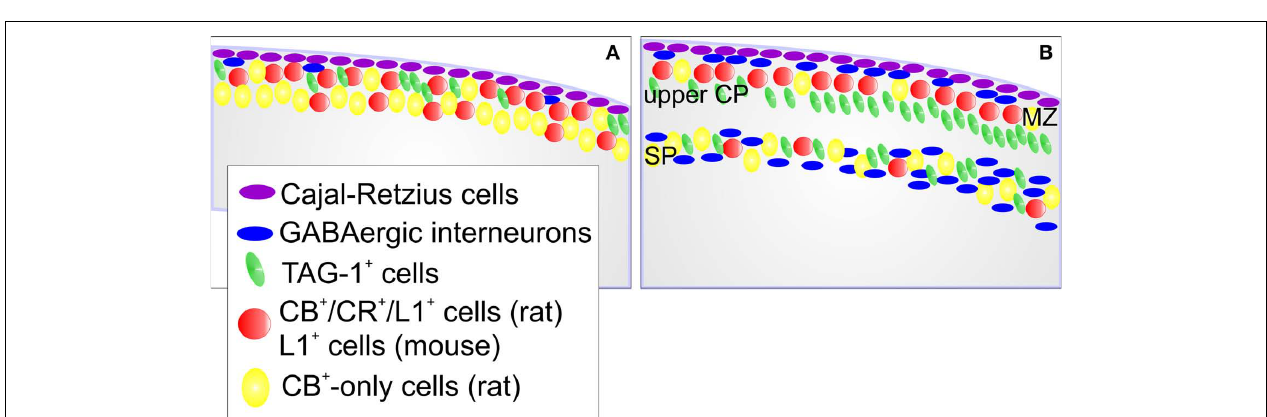
FIGURE 10 | Scheme of the cellular composition of the preplate and its derivatives in rodents. (A) Preplate stage. Cajal-Retzius cells, and sparse GABAergic interneurons are in a subpial sublayer of the preplate. Cells that express CB, CR and L1 in rats, or the homologue L1 + cells in mice, locate in the upper preplate. TAG-1 + cells are also in the upper preplate in both species. In rats, cells that express CB but not CR (CB + -only cells) tend to localize deeper in the preplate. (B) This scheme refl ects the situation immediately after preplate